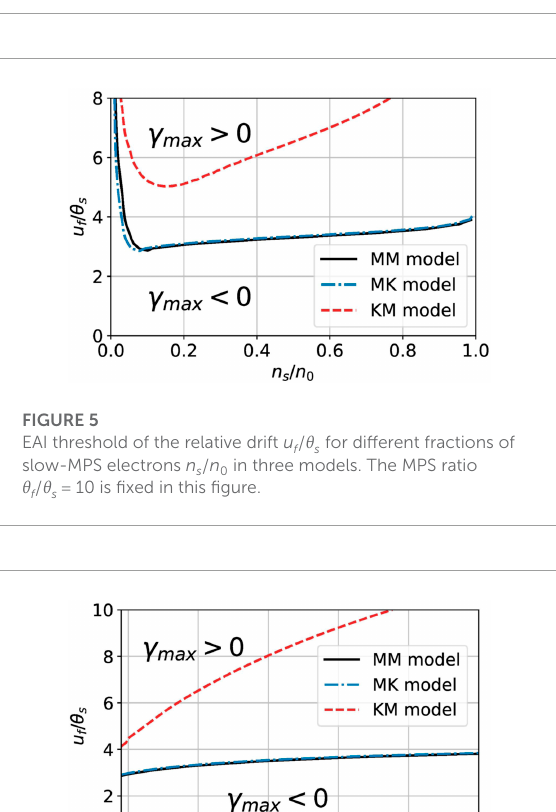
FIGURE 4 EAW growth rate for varied drift speeds. The kappa indice of three models, the MPSs, and the number densities are the same as those in Figure 1 . The legend is as same as Figure 2 .